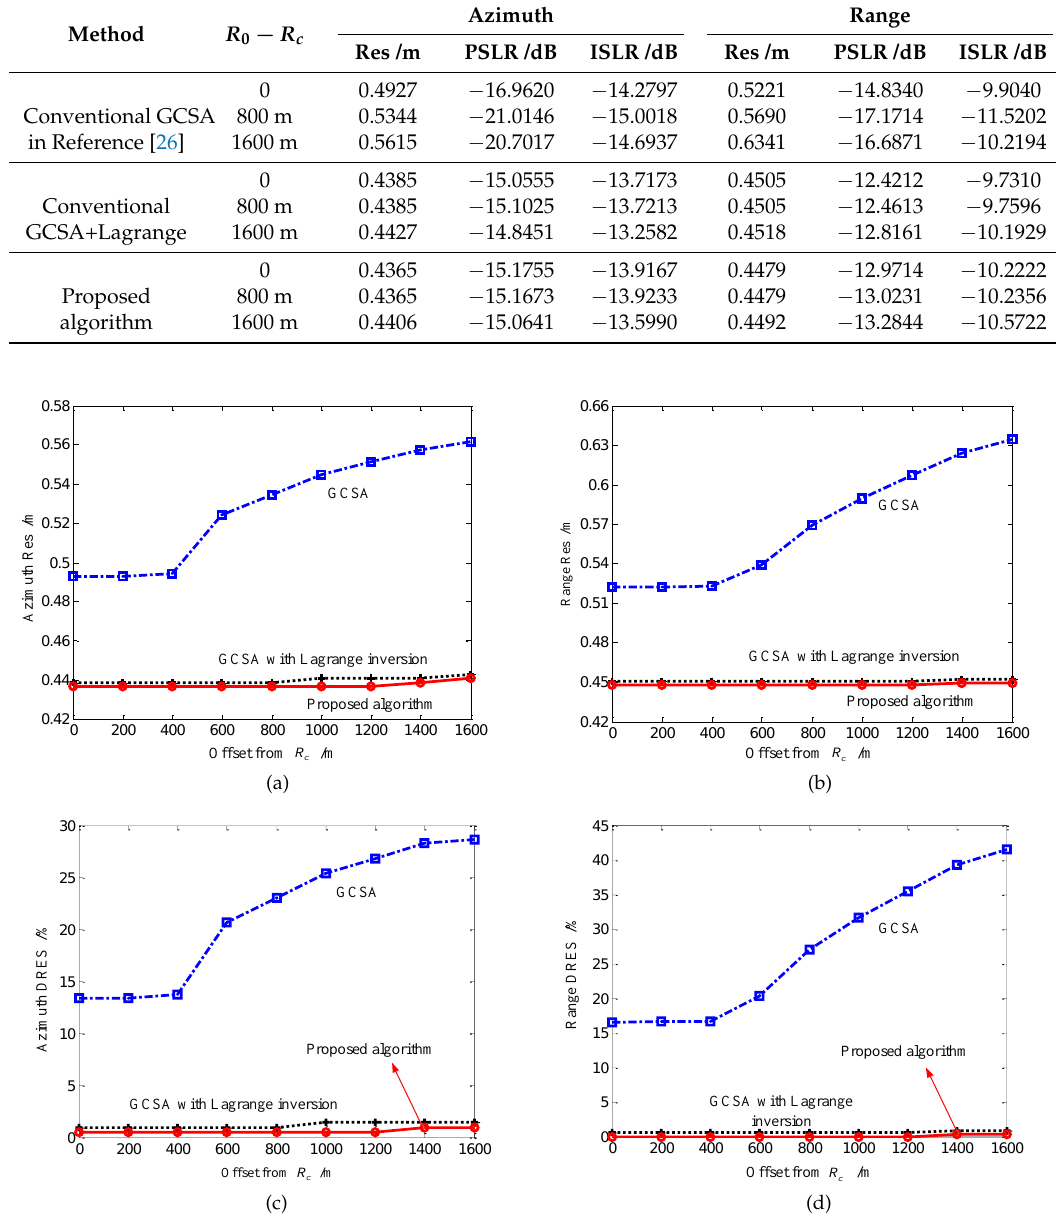
Figure 7. Resolutions (Res) and differential resolutions (DRES) in azimuth and range given by different algorithm, where the resolutions obtained by ω − k algorithm are references. The DRES presents the loss in spatial resolutions. Nine targets are arranged in the illuminated scene along the azimuth center at different distances form the reference range with an interval of 200 m. ( a ) Azimuth Res. ( b ) Range Res. ( c ) Azimuth DRES. ( d ) Range